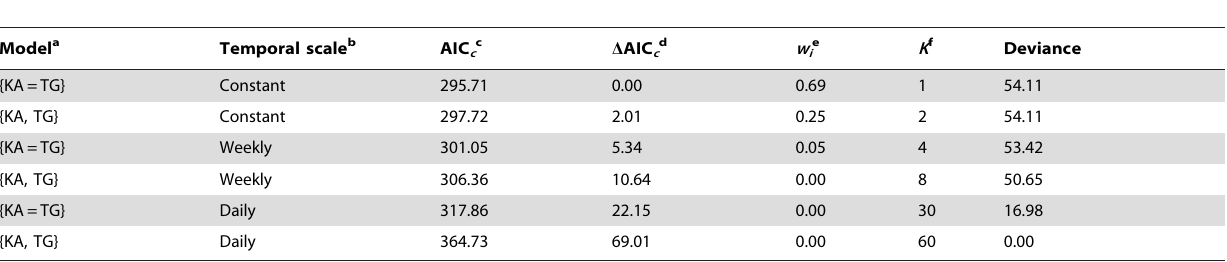
Models compared and contrasted survival rates among groups and time-dependency. a KA=known-age newborn and TG=Tucker and Garner [22] neonatal-age model. b Temporal scale represents constant, daily, or weekly survival among intervals. c Akaike’s Information Criterion corrected for small sample size [55]. d Difference in the AIC c value of the top-ranked model and that of the model under consideration. e Akaike weight [55]. f Number of parameters.